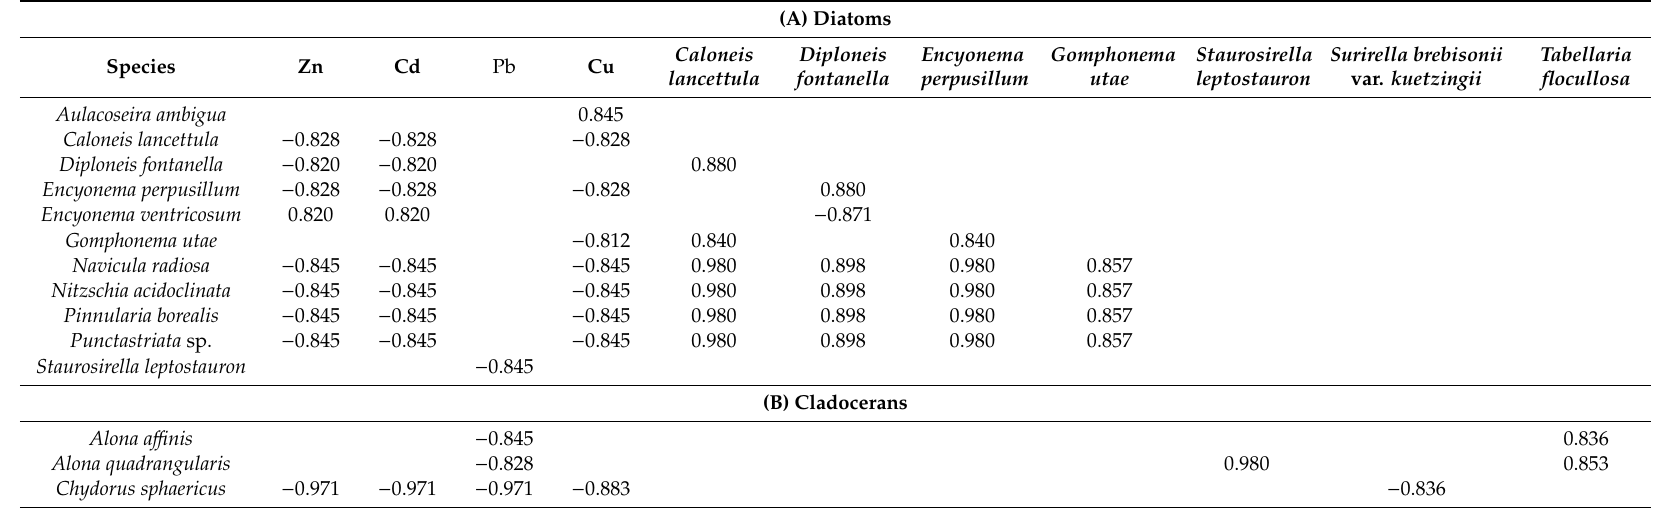
Table 6. Spearman’s rank order correlation for diatoms (A) and cladocerans (B) from sediment core of subsidence pond